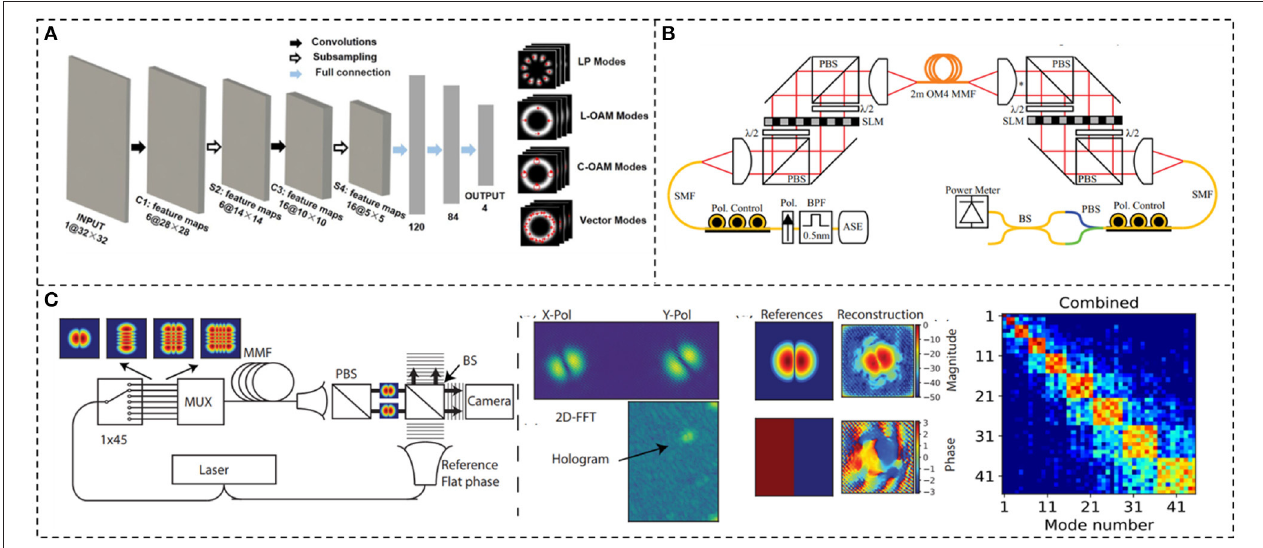
FIGURE 8 | Methods for detection of fiber-guided spatial-structured light beams. (A) Intelligent recognition of different mode bases in a ring-core fiber based on deep learning. Reprinted from Wang et al. [ 82]. (B) A fast modulation method for characterization of a 110 × 110 mode transfer matrix of 2m MMF. Reprinted from Carpenter et al. [84]. (C) Efficient characterization of a 45 × 45 mode transfer matrix of 26.5km MMF based on off-axis digital holography. Reprinted from Mazur et al. [